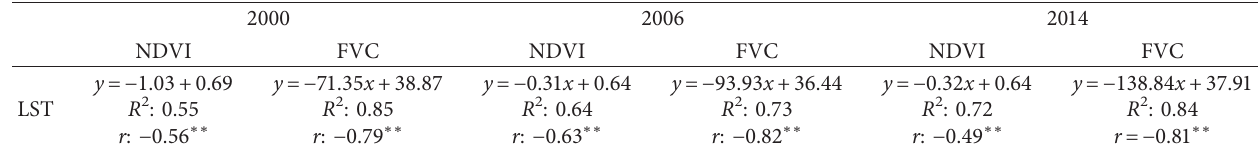
Table 4: The linear regression and correlation coefficients among LST, NDVI, and FVC.